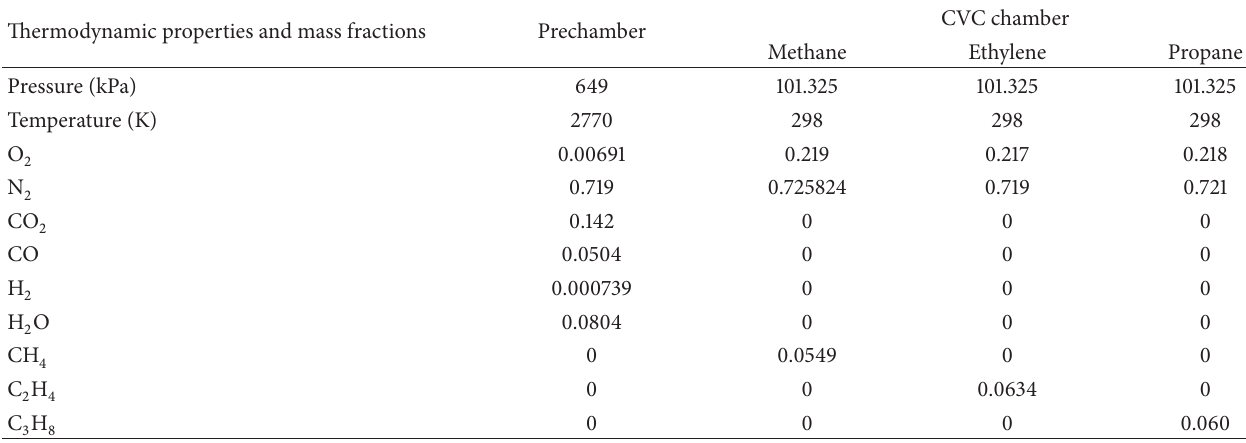
Figure 2: Geometry used for simulation. Table 1: Initial